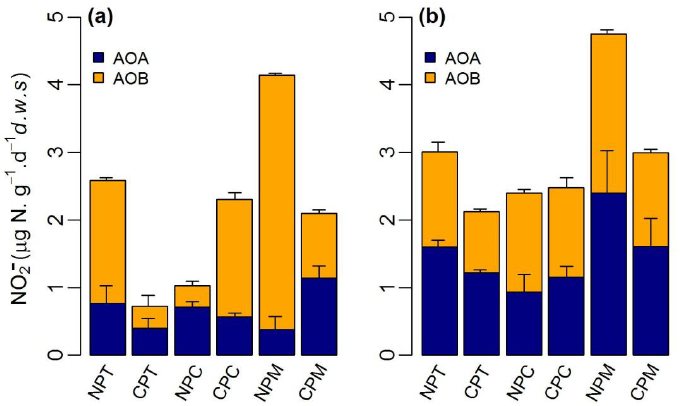
Figure 2. Relative contribution of ammonia-oxidizing archaea (AOA) and bacteria (AOB) to potential ammonia oxidiza- tion (PAO) at ( a ) 23 °C and ( b ) 37 °C. The first two digits of the soil name represent the landcover type: NP: non-cropland and CP: cropland, whereas the last digit refers to the soil location (see Table